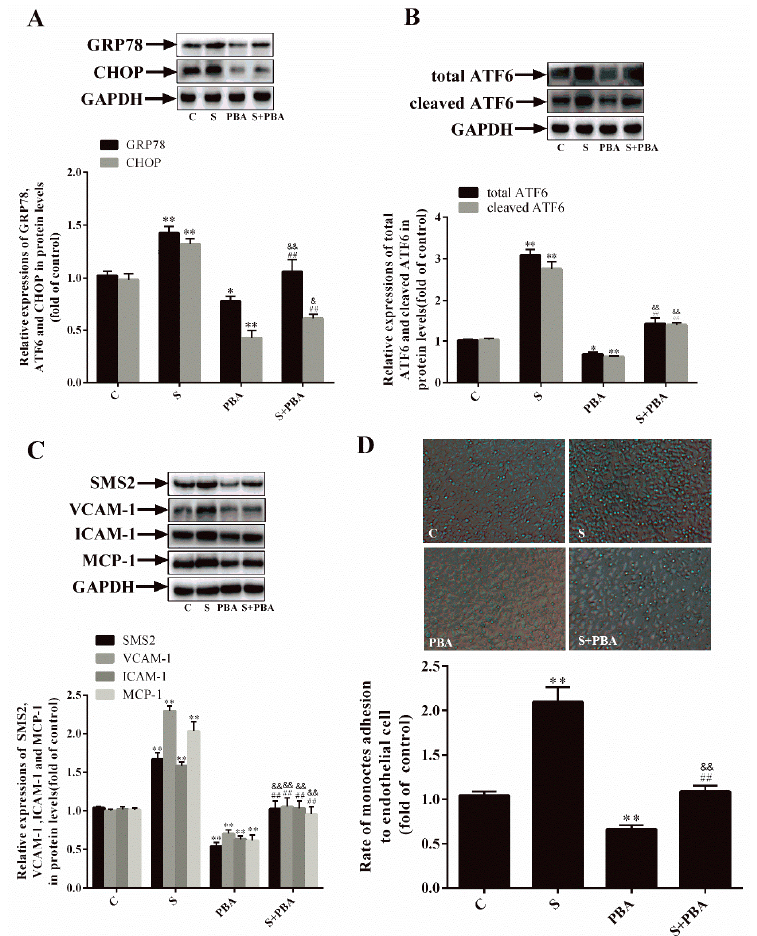
Figure 3. SMS2 can induce ER stress and endothelial dysfunction (ED) by inducing the Wnt/ β -catenin pathway. ( A ) The protein levels of GRP78 and CHOP were determined by a western blot analysis. ( B ) The protein levels of the total ATF6 and cleaved ATF6 were determined by a western blot analysis. ( C ) The protein levels of VCAM-1, ICAM-1, and MCP-1 were determined by a western blot analysis. ( D ) The adhesion ratio of THP-1 cells to HUVECs (magnification 40×). n = 3, * p < 0.05, and ** p < 0.001 vs. the C group; ## p < 0.001 vs. the S group. & p < 0.05 and && p < 0.001 vs. the PBA group. C, cells transfected with empty plasmids treated with H 2 O 2 (450 µmol/L) for 24 h; S, cells overexpressing SMS2 treated with H 2 O 2 (450 µmol/L) for 24 h; PBA, empty plasmids treated with 4-PBA (10 mmol/L) for 24 h and then treated with H 2 O 2 (450 µmol/L) for 24 h; S+PBA, cells overexpressing SMS2 treated with 4-PBA (10 mmol/L) for 24 h and then treated with H 2 O 2 (450 µmol/L) for 24 h.